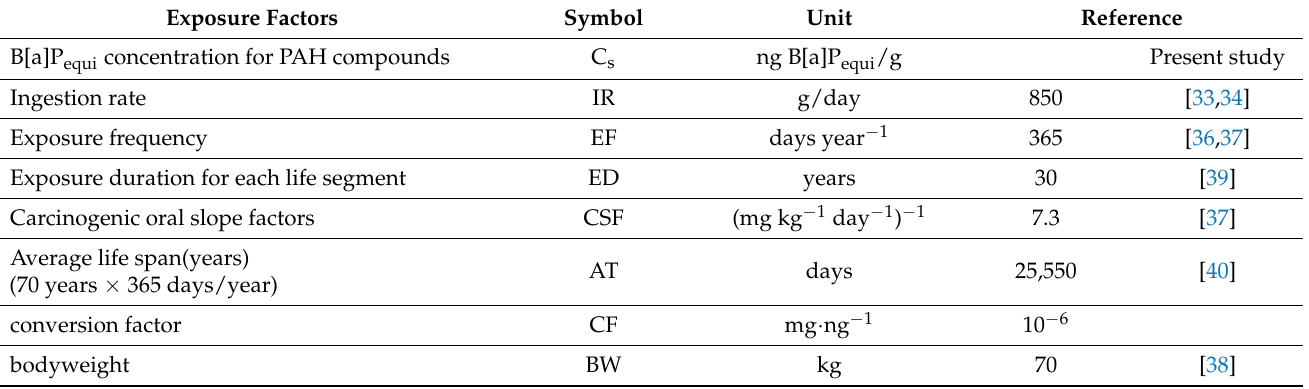
Table 3. Parameters used for estimating the exposure assessment through endemic fish